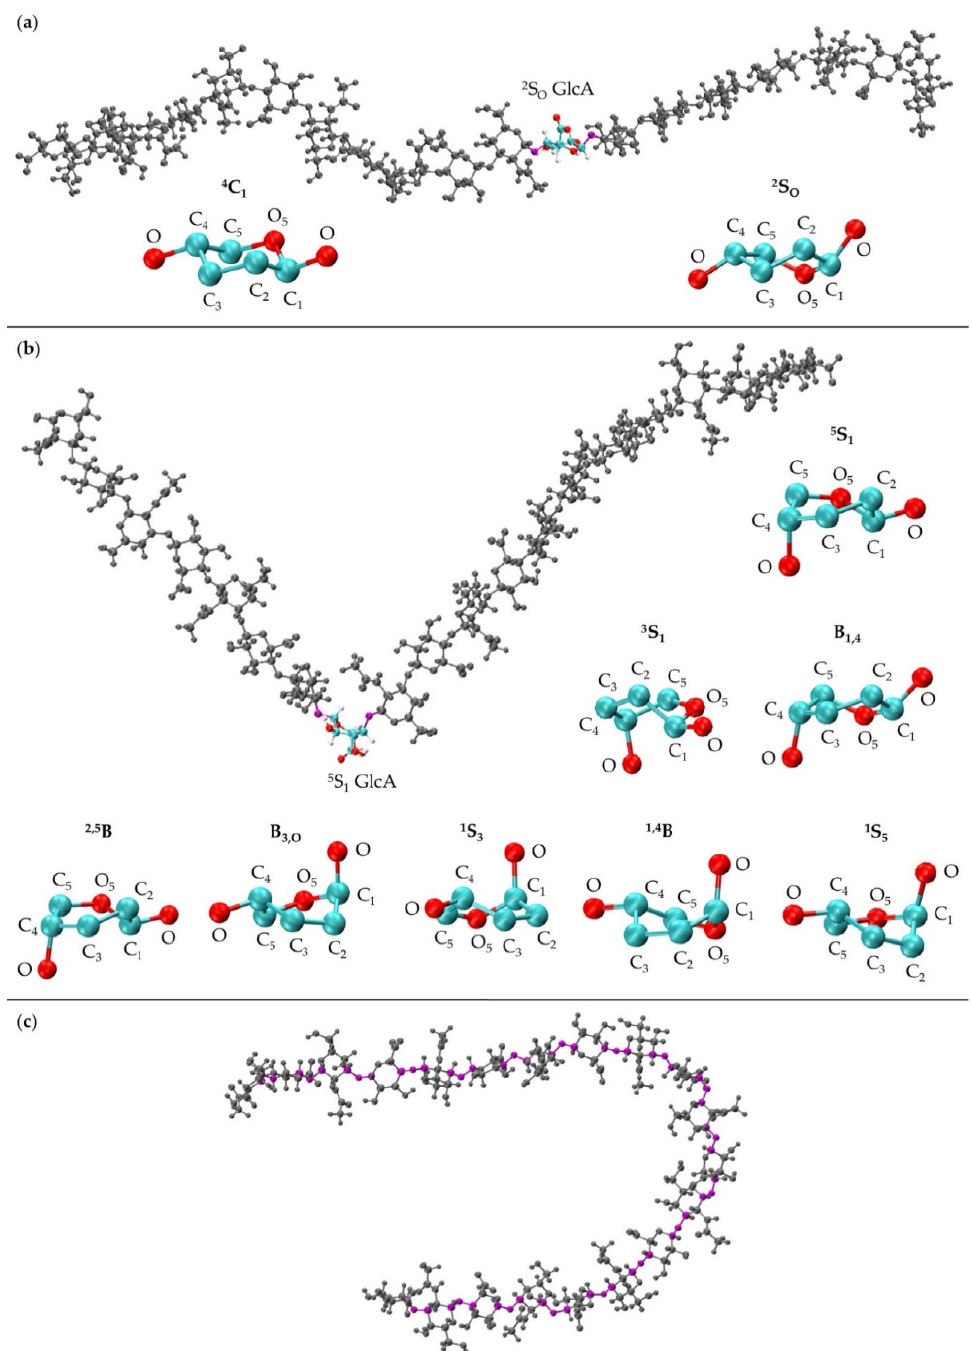
Figure 5. ( a ) 20 ‐ mer conformation with a 2 S O GlcA conformer (colored by atom type with flanking linkage atoms highlighted in purple) and close ‐ ups of GlcA monosaccharide rings in 4 C 1 and 2 S O conformations (shows endocyclic ring atoms and linker oxygen atoms only); ( b ) 20 ‐ mer conformation with a kink at a 5 S 1 GlcA conformer (colored by atom type with flanking linkage atoms highlighted in purple) and GlcA monosaccharide rings in 5 S 1 , 3 S 1 , B 1,4 , 2,5 B, B 3,O , 1 S 3 , 1,4 B, and 1 S 5 conformations (shows endocyclic ring atoms and linker oxygen atoms only); ( c ) 20 ‐ mer conformation with a curve caused by flexible glycosidic linkage geometries (highlighted in purple) and all monosaccharides in 4 C 1 conformations; all images came from MD ‐ generated ensembles.